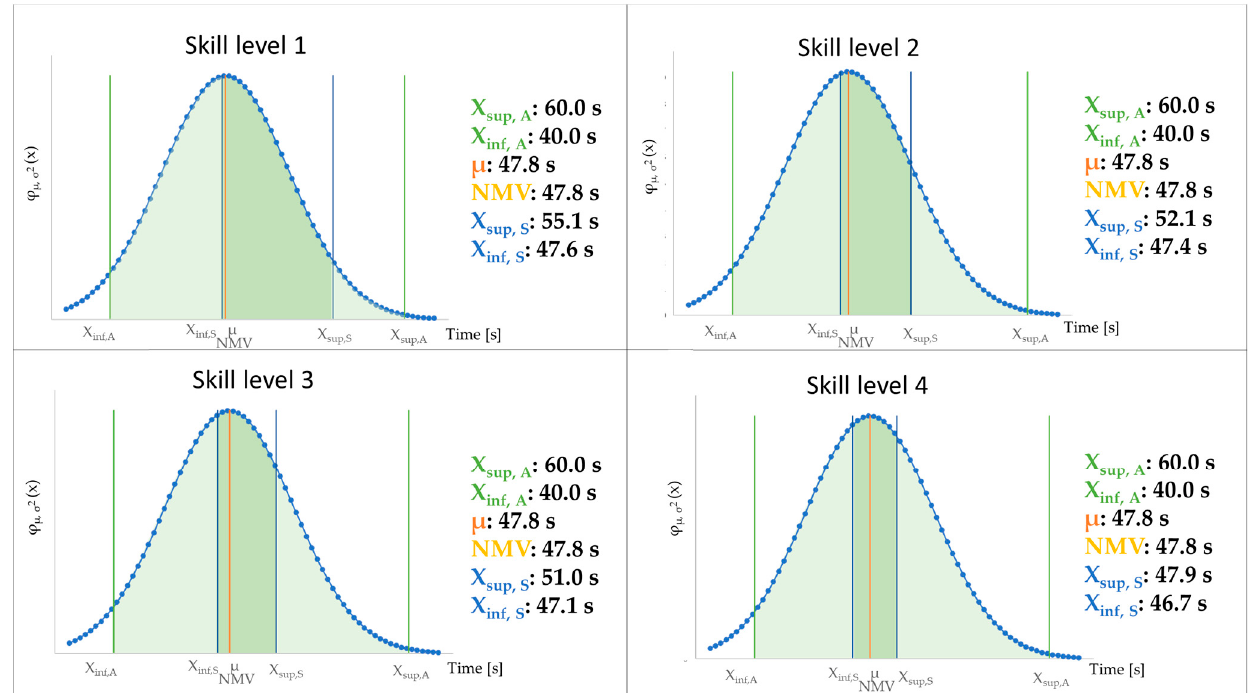
Figure 17. Gaussian distribution of welding.